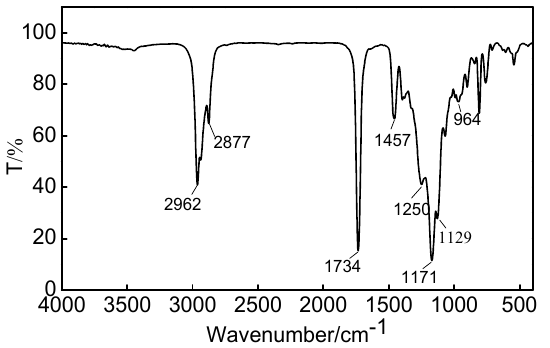
Figure 9. FT-IR spectrum of OFAE-SA-BA.